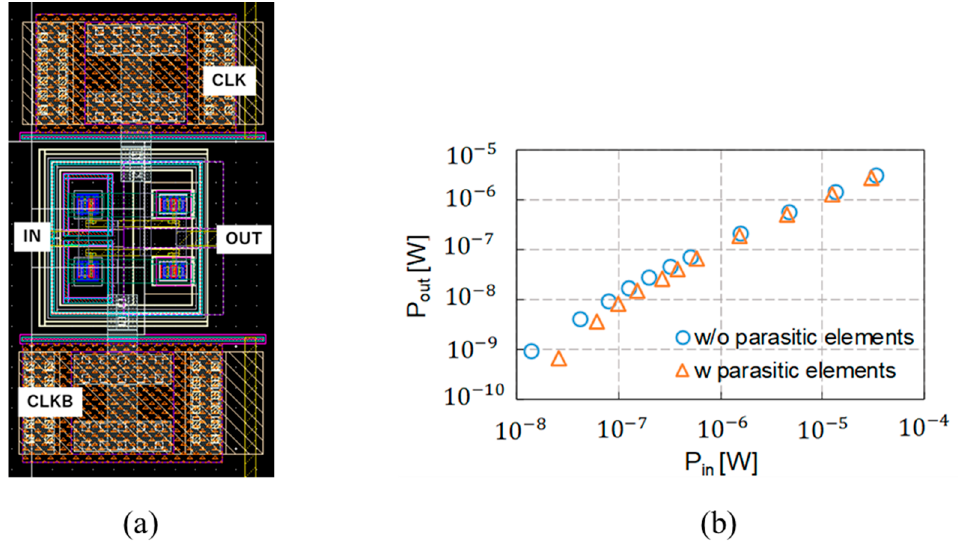
Figure 7. Stage layout of CMOS latch rectifier ( a ) and P in − P out with and without parasitic elements of CLK/CLKB wires ( b ).